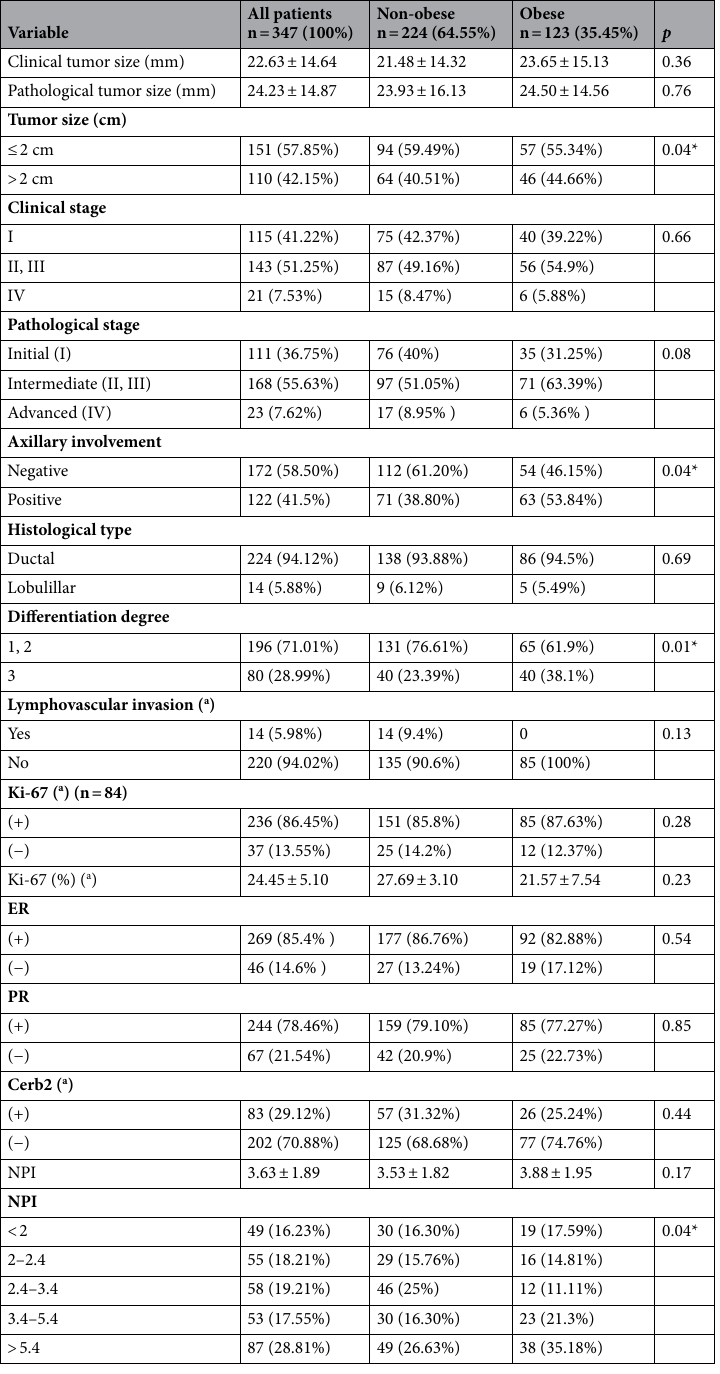
Table 5. Prognostic tumor characteristics in breast cancer patients according to their BMI (obese vs. non- obese). Data expressed as means ± standard deviation and absolute numbers and their frequencies. NPI Nottingham prognostic index. * p value < 0.05 (t-Student or Chi-squared). a Analysis performed on the cases provided by the pathology